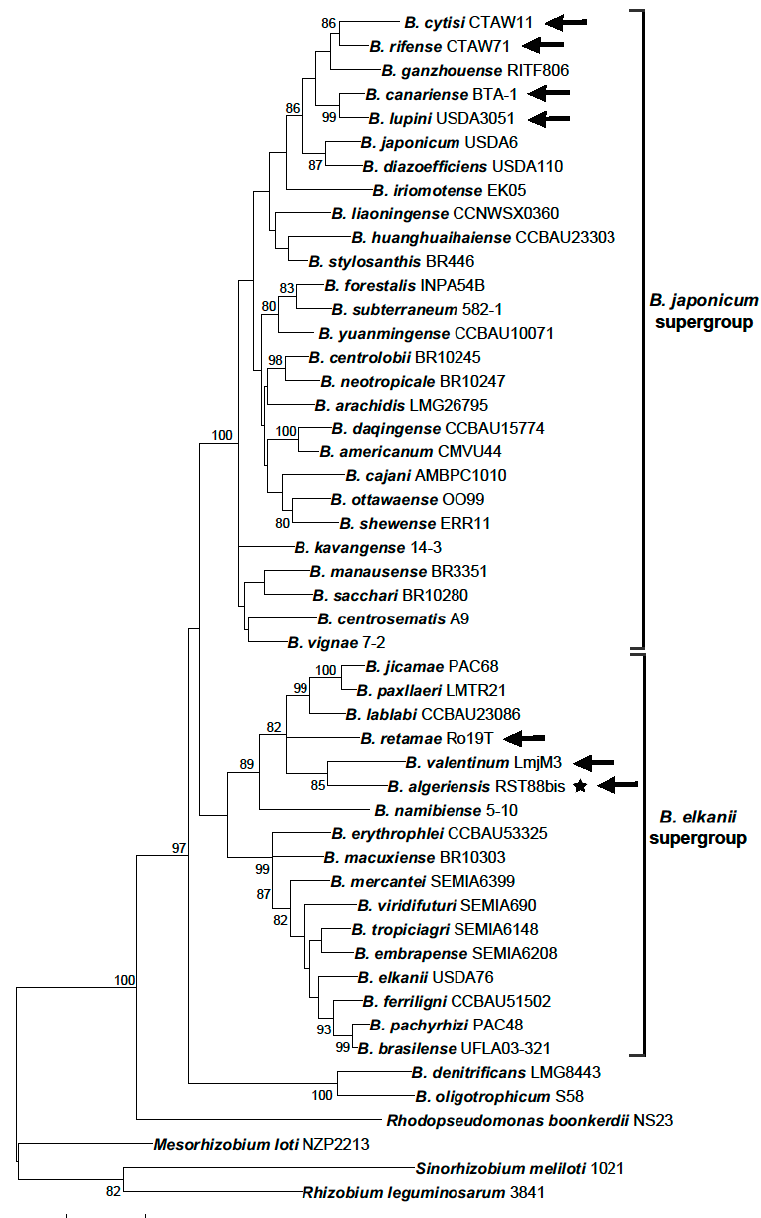
Figure 2. Maximum likelihood (ML) phylogeny of concatenated recA and glnII partial gene sequences (425 bp + 519 bp), comprising type strains of Bradyrhizobium species with the exception of species, in which recA sequences were missing: Bradyrhizobium betae LMG 21987, Bradyrhizobium guangdongense CCBAU 51649, Bradyrhizobium guangxiense CCBAU 53363, Bradyrhizobium icense LMTR 13 and Bradyrhizobium ingae BR 10250. The scale bar indicates the number of substitutions per site. Bootstrap values >70% (percentage of 500 replicates calculated under distance criteria) are given at the branching nodes. The sequences of Rhodopseudomonas boonkerdii NS23, M. loti NZP2213, Sinorhizobium meliloti 1021 and R. leguminosarum 3841 were used as outgroups. The sequences were aligned using ClustalW software and ML phylogenies were inferred with Mega 6 [17] using the best-fit nucleotide substitution models as indicated by jModelTest 2.1.4. [115]. The distances were calculated according to the GTR+I+G model. Arrows indicate Bradyrhizobium species that nodulate Genisteae plants. Asterisk denotes Bradyrhizobium algeriensis, which has not been formally